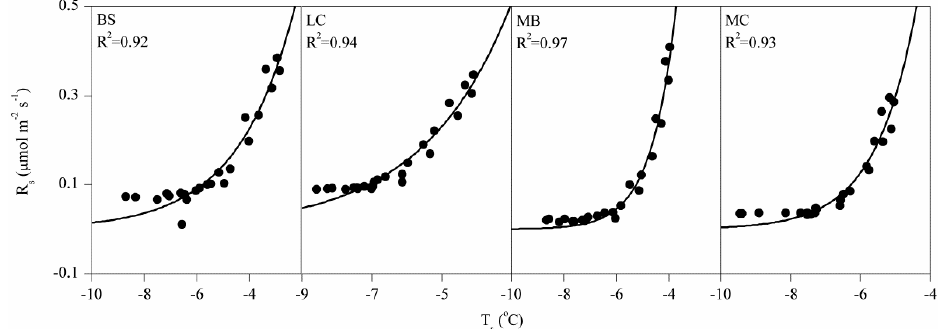
Table 1. Winter soil respiration (R s ) and its contribution to annual total of R s for four microsites including bare surface (BS), lichen crust (LC), moss crust (MC), and mixed crust of both moss and Figure 6. Mean diurnal soil respiration (R s ) in relationship to soil temperature (T s ) on days where the Figure 6. Mean diurnal soil respiration (R s ) in relationship to soil temperature (T s ) on days where the lichen (ML) a . soil remained frozen, for four microsites including bare surface (BS), lichen crust (LC), moss crust soil remained frozen, for four microsites including bare surface (BS), lichen crust (LC), moss crust (MC), (MC), and mixed crust of both moss and lichen (ML). and mixed crust of both moss and lichen (ML).